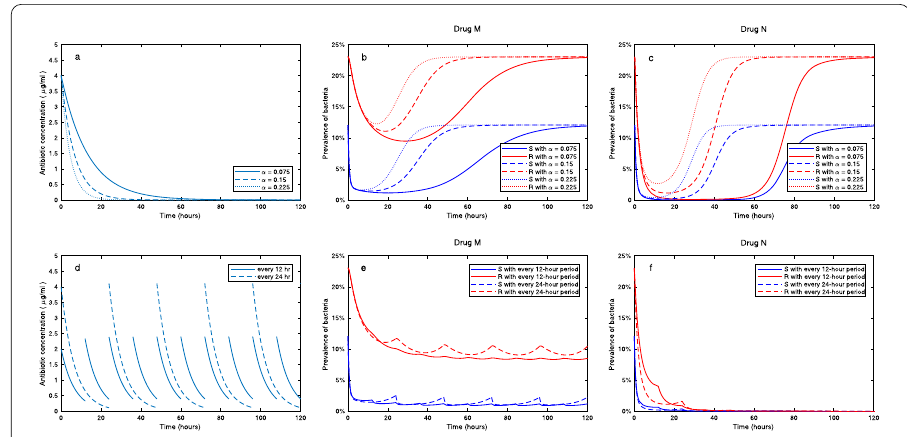
Figure 5 Investigationofantibioticregimensafterresistantbacteriaareprevalent . Two types of antibiotics are considered: drug M that kills only sensitive bacteria and drug N that kills both sensitive and resistant bacteria. ( a ) Antibiotic concentration profile when the elimination rate varies ( α = 0.075—solid line, α = 0.15—dash line, and α = 0.225—dot line). ( b ) & ( c ) Prevalence of sensitive and resistant bacteria according to the elimination rate when drug M and N are administered, respectively. ( d ) Two concentration profiles when two drug regimens are considered with the same total dose: every 12 hours and every 24 hours. ( e ) & ( f ) Prevalence of sensitive and resistant bacteria according to two drug regimens when drug M and N are given, respectively ( S (0) = 1.2 × 10 8 and R (0) = 2.3 × 10 8